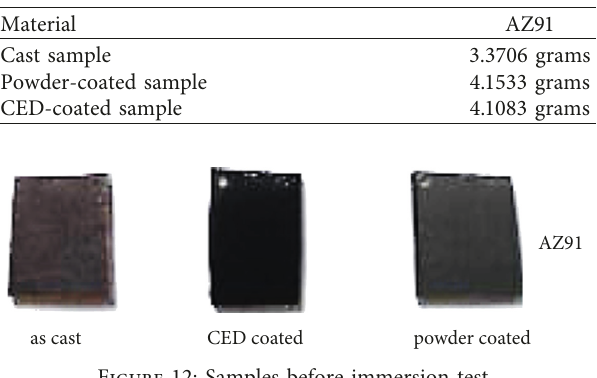
Table 8: Weight of samples before immersion test.